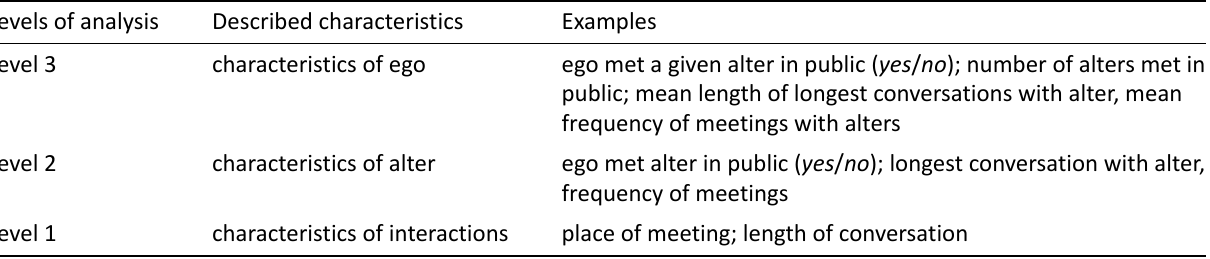
Table 1. Different levels of analysis in the contact diary and the steps of